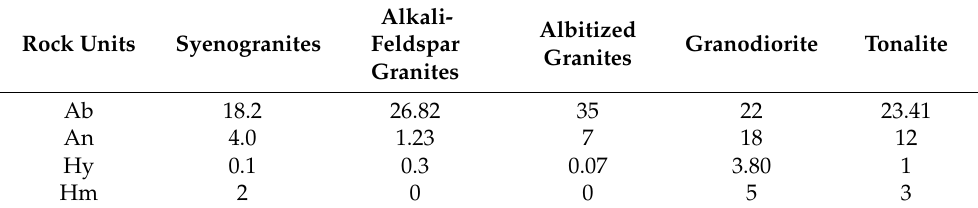
Figure 3. Classification and magma-type diagrams of Homrit Waggat rocks using: ( a ) SiO 2 vs. Na 2 O + K 2 O diagram [18]; ( b ) Ab-Or-An normative diagram [19]; ( c ) SiO 2 vs. K 2 O diagram [20]; and ( d ) 10,000*Ga/Al vs. K 2 O/MgO diagram [21]. It is noticeable that the studied Homrit Waggat rocks have high-K calc-alkaline affin- ity, whereas tonalite-granodiorite and albitized granites have medium-K calc-alkaline af- finity [20] (Figure 3c). The rocks studied have alumina saturation indices (A/CNK = Al 2 O 3 /CaO + Na 2 O + K 2 O) greater than 1.1 (1.71–2.27), suggesting their peraluminous char- acter [22]. In addition, they possess agpaitic indices (AI) lower than 0.87, indicating calc- alkaline characteristic. Among the Homrit Waggat rocks, tonalite-granodiorite rocks have low K 2 O/MgO content, reflecting I- and S-type affinity (Figure 3d), while other rock sam- ples occupy A-type field [21]. It is noticeable from multi trace elements that are normalized to primitive mantle [23] that tonalite-granodiorite patterns reveal enrichment of low-field-strength elements (LFSEs) relative to high-field-strength-elements (HFSEs), with positive Ba, Pb, and Sr anomalies as well as negative Nb anomaly, reflecting subduction affinity (Figure 4a). On the contrary, other granitic types exhibit strong positive Rb anomaly without negative Nb